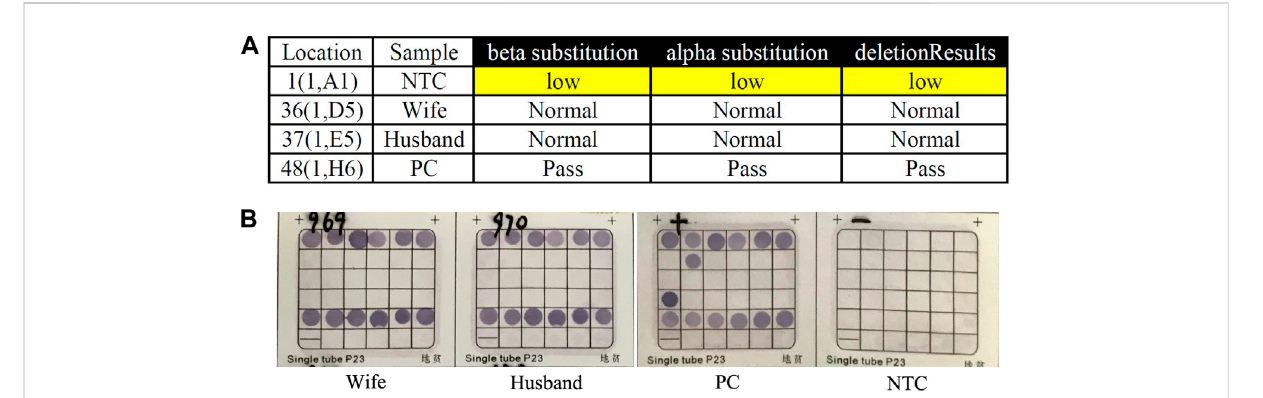
FIGURE 1 Routine genetic assays for 23 types of variations in HBA and HBB genes. (A) Auspension-array system was performed to detect 23 types of common variations in thalassemia. (B) Reverse dot blot (RDB) assay was used to detect 23 types of common variations in thalassemia (PC was β 17M/N and α – SEA/N ). No routine variants in thalassemia had been detected in this couple by this two independent platforms (NTC: No Template Control; PC: Positive Control; Pass: Quality Control